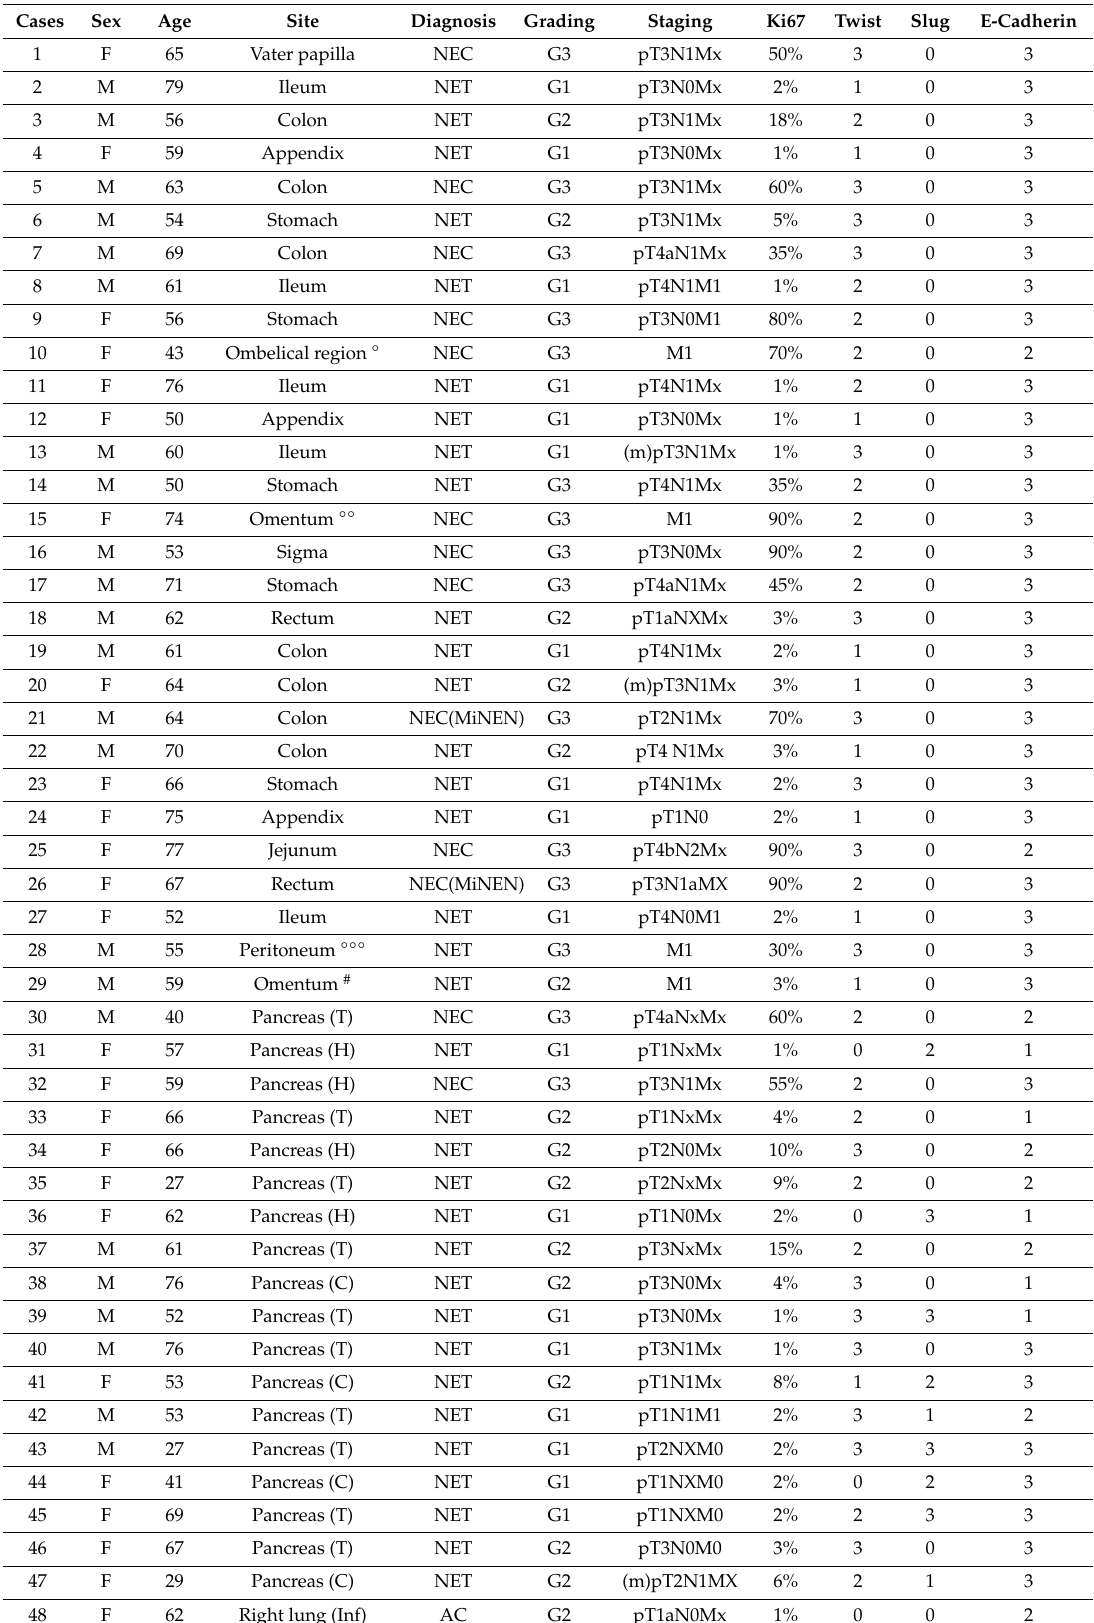
Table 2. Clinico-pathological features of 64 study